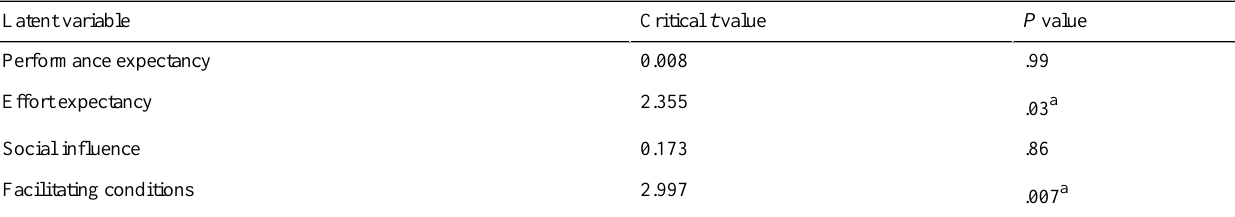
Table 7. Pre- or postmultigroup